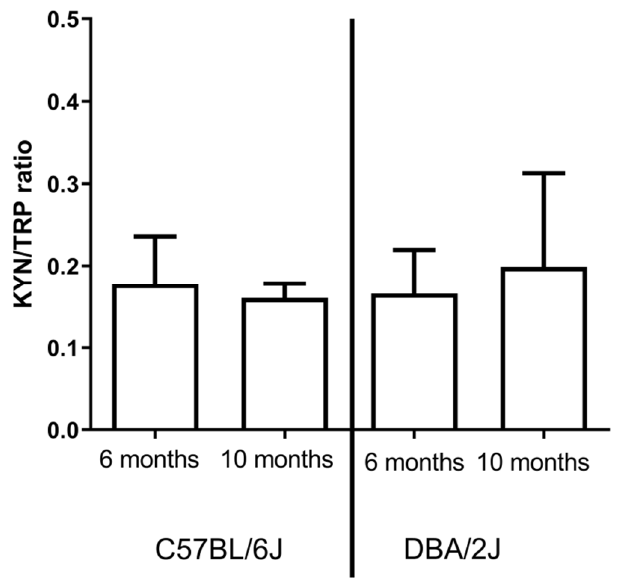
Figure 5. Indoleamine 2,3 dioxygenase (IDO) activity was expressed as a kynurenine/tryptophan ratio in the serum of C57BL/6 and DBA/2J mice.